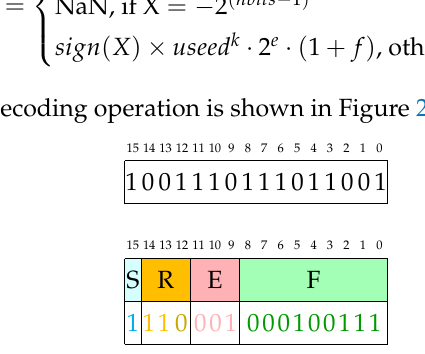
Figure 2. An example of a 16-bit Posit with 3 bits for the exponent ( esbits = 3): Given the sequence